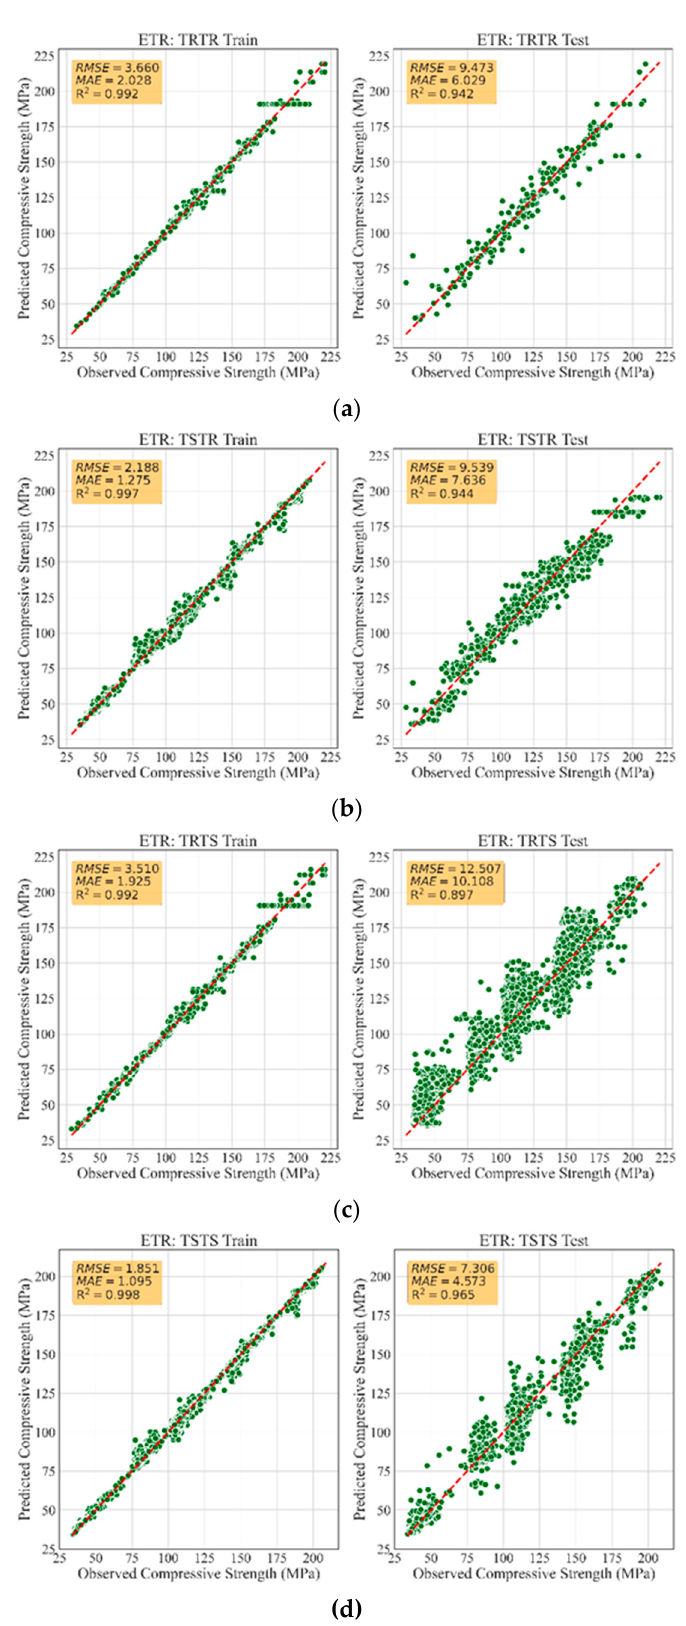
Figure 4. Training and testing performance of ETR model: ( a ) TRTR; ( b ) TSTR; ( c ) TRTS, and ( d ) TSTS.